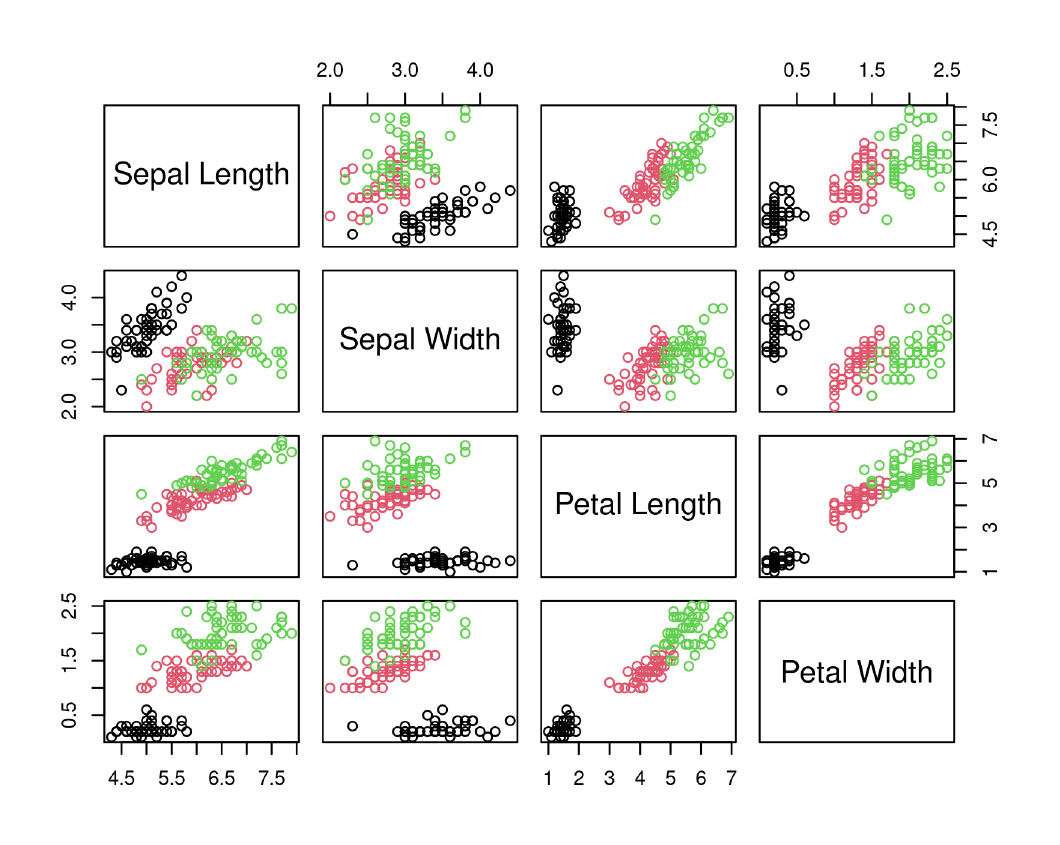
Figure 11. Iris dataset [37]. Black circles represent the setosa species of iris flower. The red circles are versicolor and the green circles are